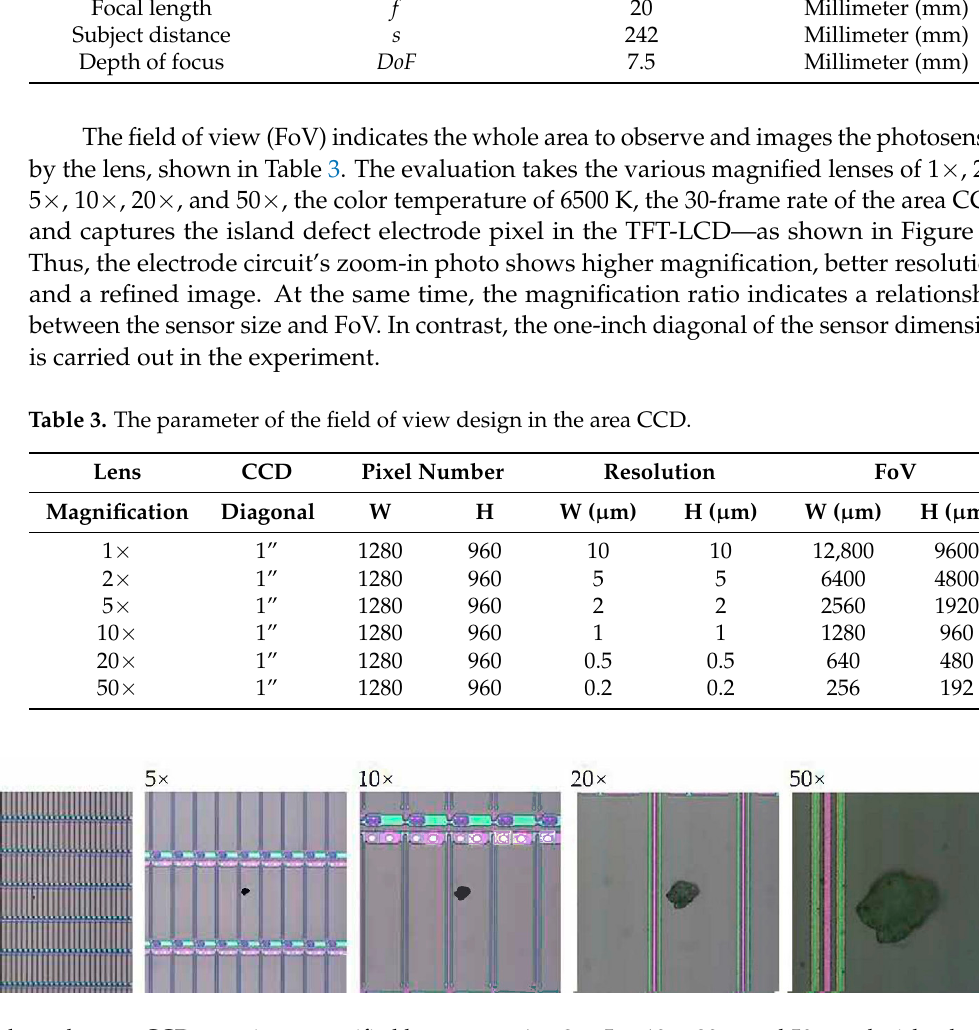
Figure 15. The captured photos by area CCD at various magnified lenses were 1×, 2×, 5×, 10×, 20×, and 50× at the island defect of the electrode in TFT-LCD.